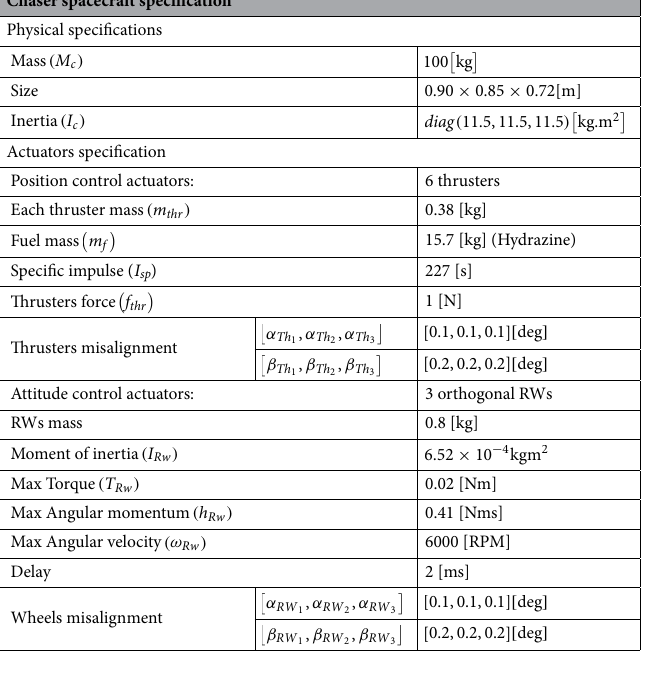
Table 3. Chaser spacecraft specifications.